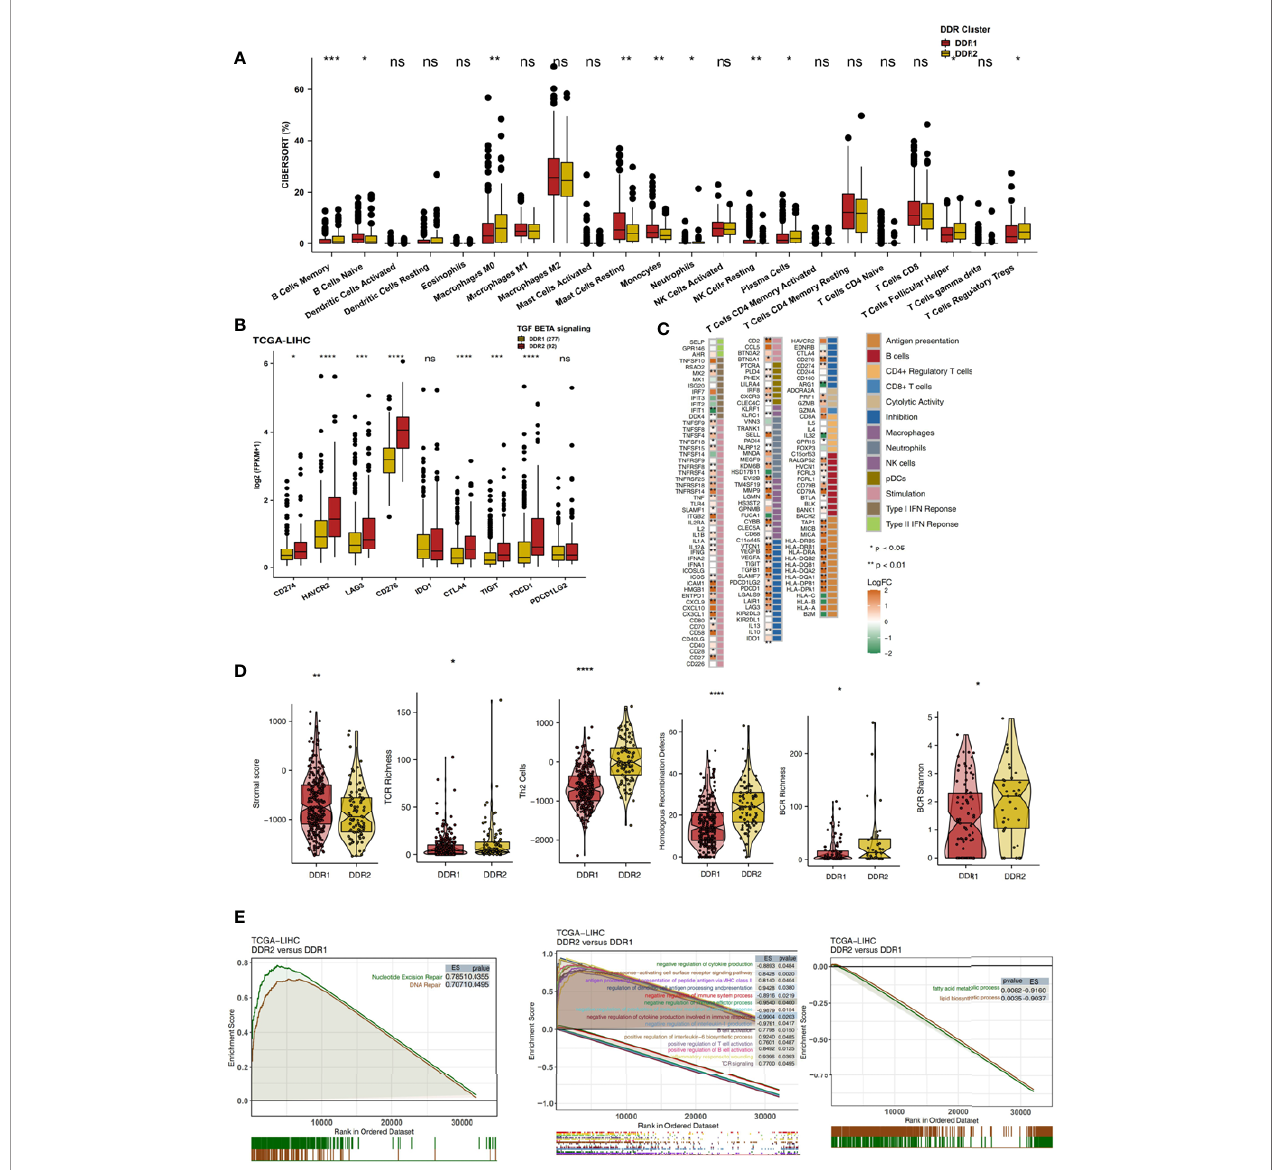
FIGURE 4 | (A) Comparison of the proportions of 22 immune cells estimated by CIBERSORT between two molecular subclasses (DDR1 and DDR2) in the TCGA- LIHC cohort. (B) Comparison of the expression levels of immune checkpoint molecules between two molecular subclasses (DDR1 and DDR2) in the TCGA-LIHC cohort. (C) Heatmap depicting the mean differences in immune-related gene mRNA expression between two molecular subclasses (DDR1 and DDR2) in the TCGA- LIHC cohort. The y-axis indicates the gene names. Each square represents the fold change of or difference in each indicated immune-related gene between DDR1 and DDR2 tumors in the TCGA-LIHC cohort. Red indicates upregulation, while blue indicates downregulation. (D) Comparison of the immune signature scores between two molecular subclasses (DDR1 and DDR2) in the TCGA-LIHC cohort. (E) Biological function pathways, such as DNA repair, immune-related and immune- exhausted pathways, identi fi ed as enriched between DDR1 and DDR2 tumors in the TCGA-LIHC cohort. GSEA of hallmark gene sets downloaded from MSigDB. All transcripts were ranked by the log2 (fold change) value between DDR1 and DDR2 tumors. Each run was performed with 1,000 permutations. Pathways with signi fi cant enrichment between DDR1 and DDR2 tumors are shown. (ns, not signi fi cant; *P < 0.05; **P < 0.01; ***P < 0.001; ****P < 0.0001; Mann-Whitney U